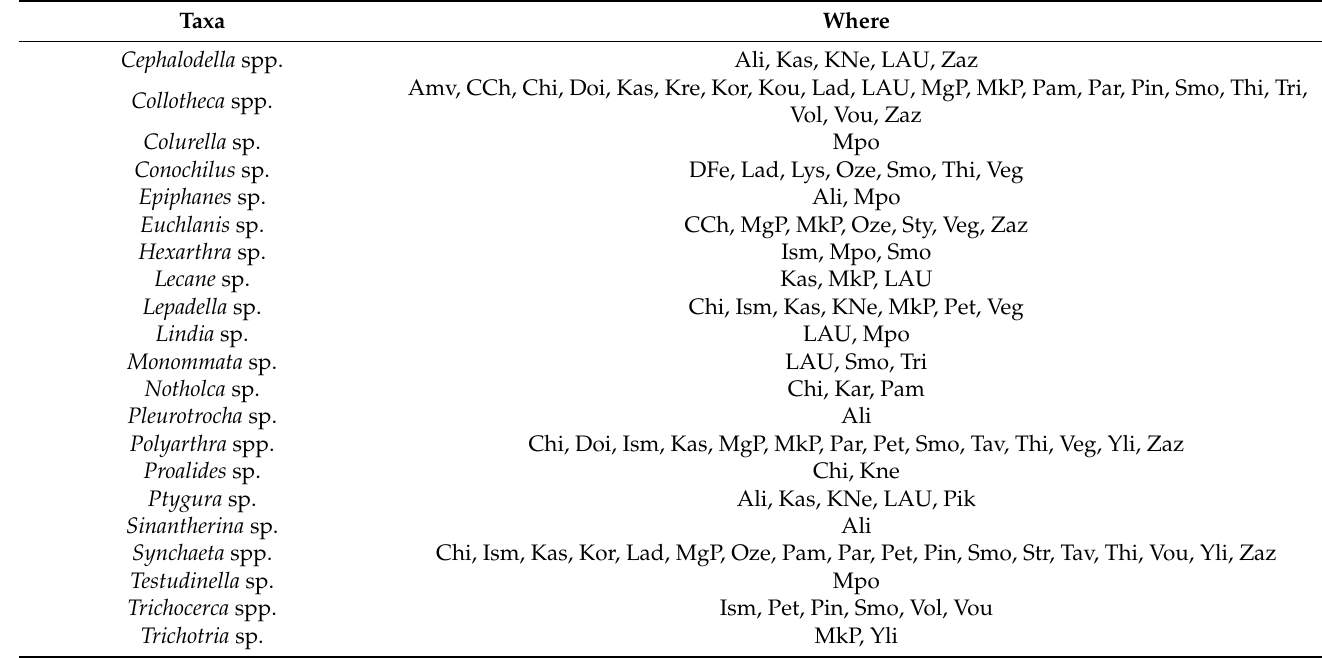
Table 3. List of taxa identified down to the genus